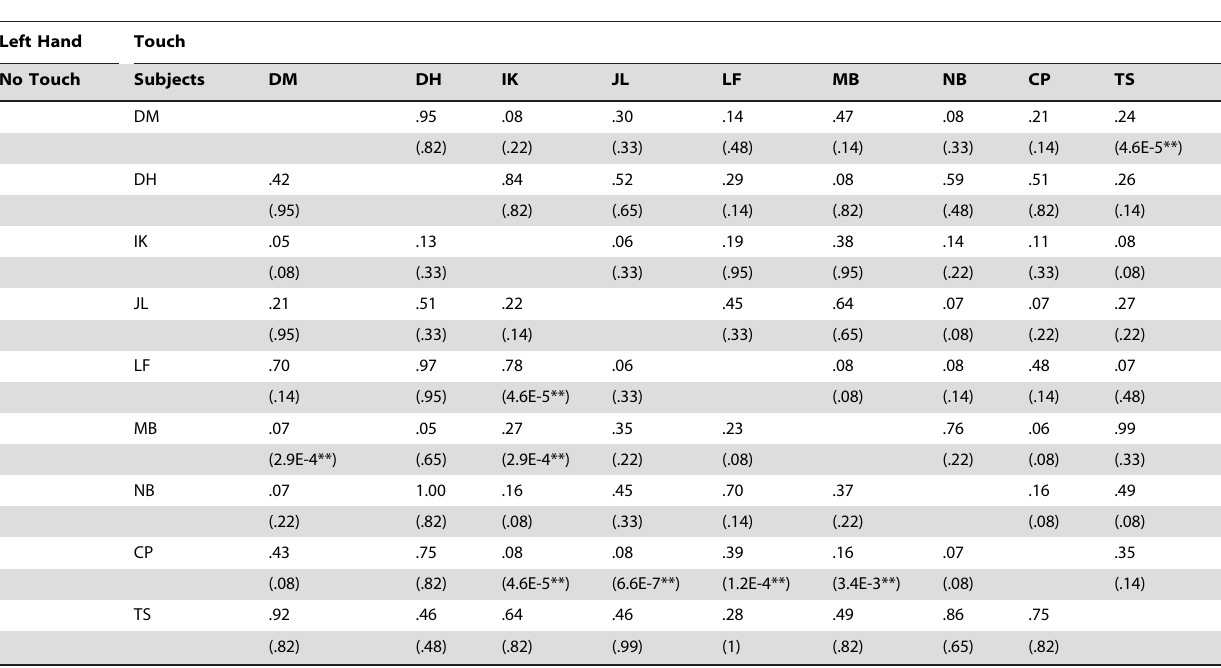
Table 3. Test of Similarity Between Subjects for the Left hand: Resulting p-values from the K-S test.